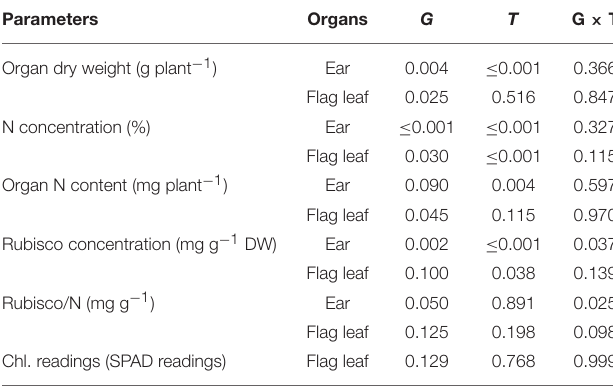
readings (SPAD readings) during anthesis and grain filling for four Chinese winter wheat genotypes grown in pots.